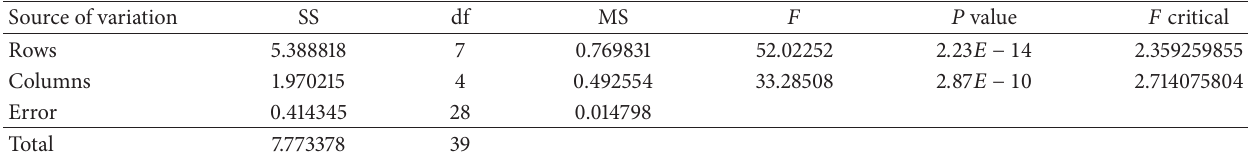
Table 7: Stability test results (ANOVA: two-factor without replication).